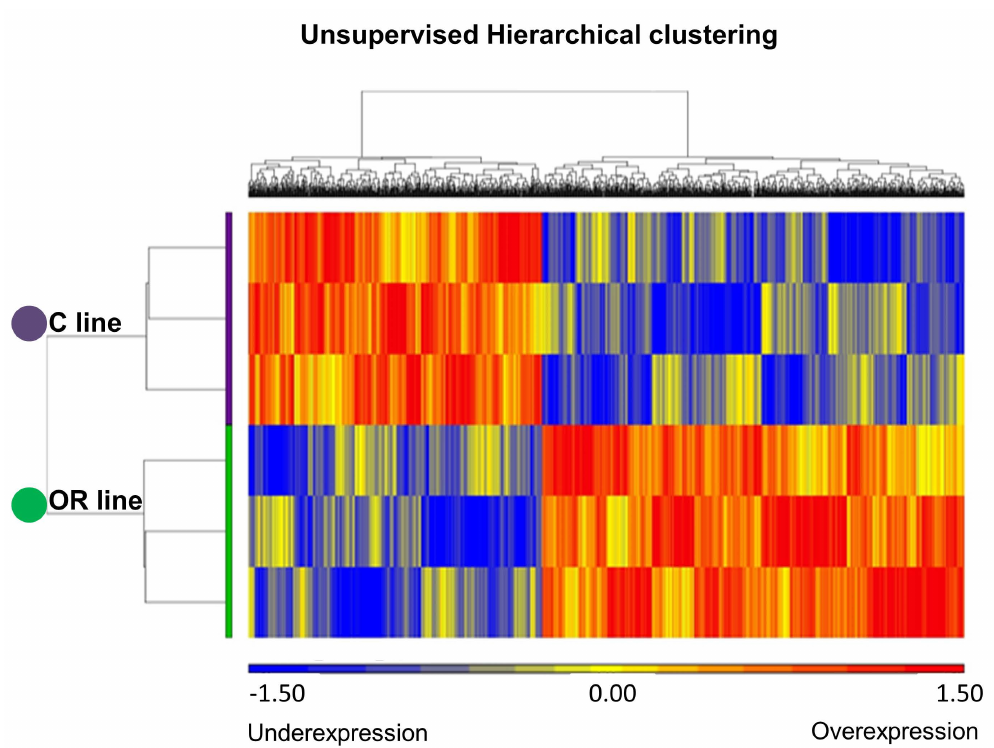
Figure 2. Unsupervised hierarchical clustering of 1357 di ff erentially expressed genes in ovarian tissue. In purple, the control line (C line) clustered a completely di ff erent manner than the ovulation rate selected line (OR line, in green). Each line represents a sample and each column a gene. Overexpressed genes are represented in red and underexpressed genes in blue.